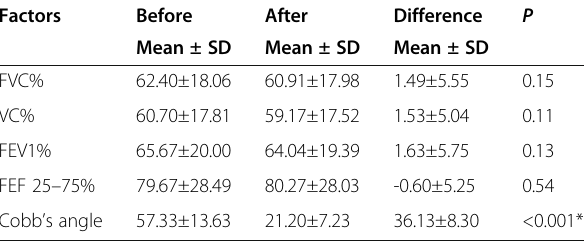
Table 2 Pulmonary function test and Cobb ’ s angle before and after